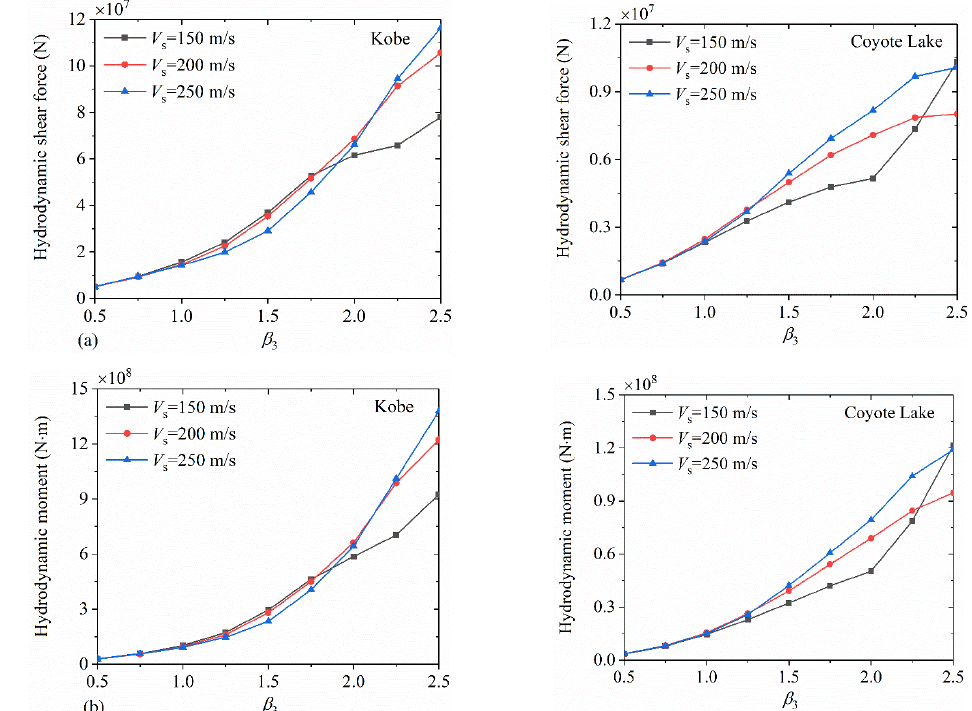
Figure 19. Effect of the liquid height on hydrodynamic responses: ( a ) the shear force; ( b ) the overturning moment.